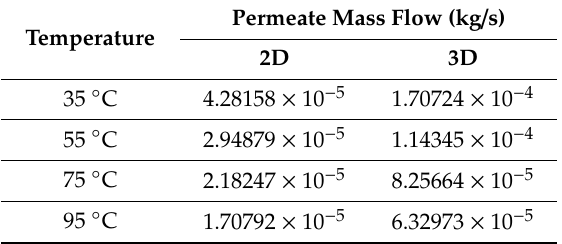
Figure 7. Permeation velocity as a function of axial position along the membrane (Cases 1–8). Table 7. Permeate mass flow for different temperatures.